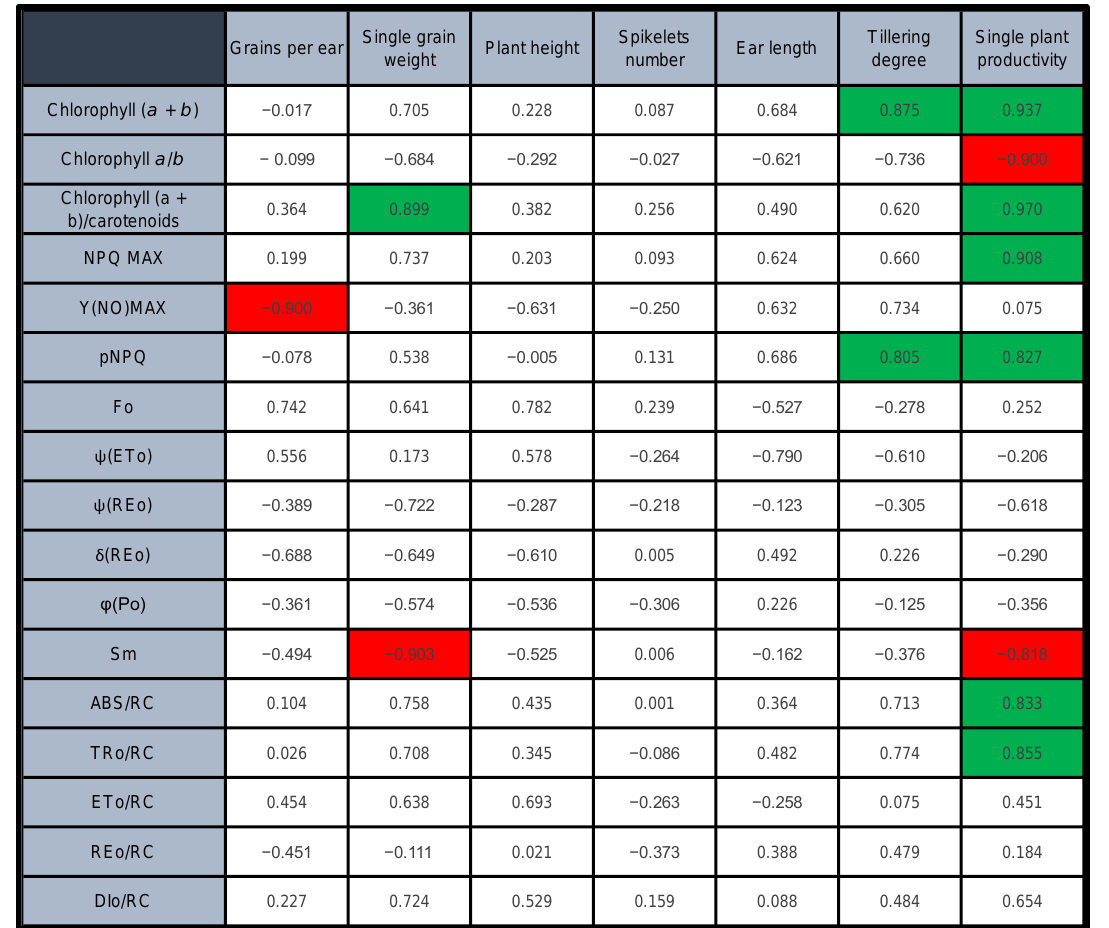
Figure 7. Matrix of Pearson ’ s r correlation coefficients of photosynthetic parameters vs. productivity parameters in durum- and bread-wheat lines. Correlations were constructed with average values of the measurements performed in the young plants using Microsoft Office Excel TM (Microsoft). Green colour marks significant positive correlations, red the negative ( p < 0.05).